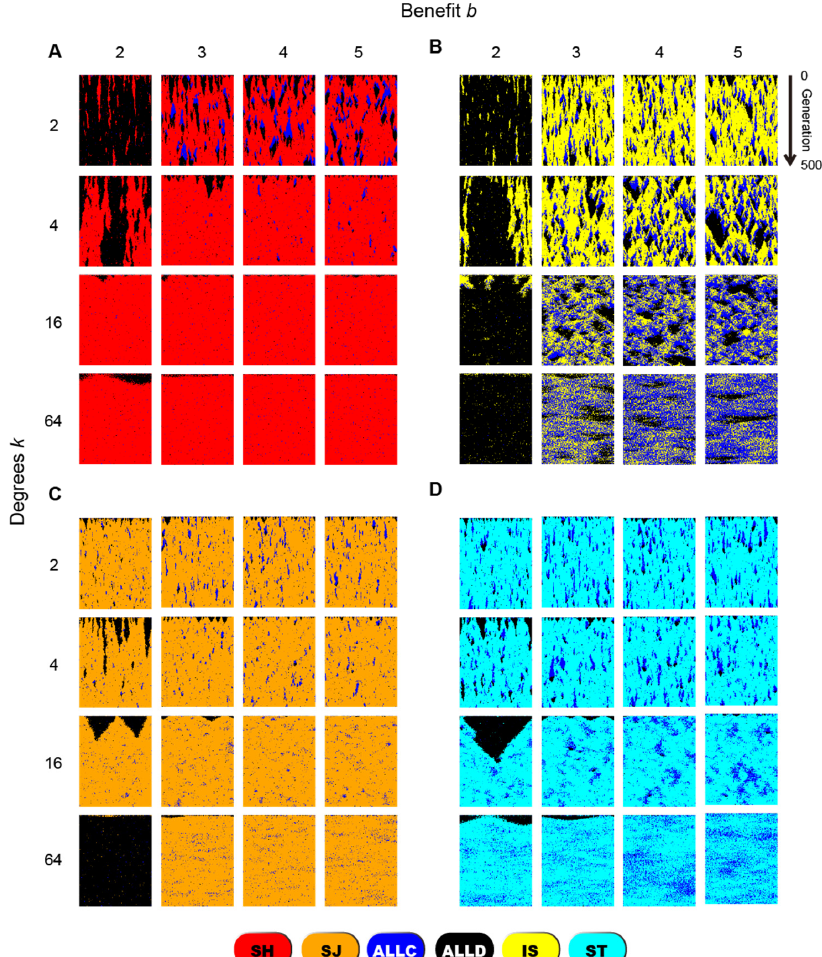
Figure 4. Evolution of spatial patterns of indirect reciprocity on regular ring lattices with indirect observation and public assessment errors. ( A ) Shunning (SH) (red color) and ( C ) stern judging (SJ) (orange color) are likely to take over the population. SJ can also achieve almost full cooperation; yet, in SH, the cooperation rate is low; ( B ) image scoring (IS) (yellow color) is most likely to lead to a three-strategy dynamical coexistence, in which case, the strategy is adopted by each node change frequently. As increases are seen in benefit b and node degree k , the average cluster size of IS decreases, becoming replaced with an ALLC; ( D ) simple standing (ST) (cyan color) is most likely to maintain a state that is exclusively mixed with DISCs and ALLCs. Parameters: g = 500 generations, h = 50 periods, error rates p = q = 0.01 (both for implementation and public assessment errors), selection intensity s = 1, mutation rate m = 0.01, and c =